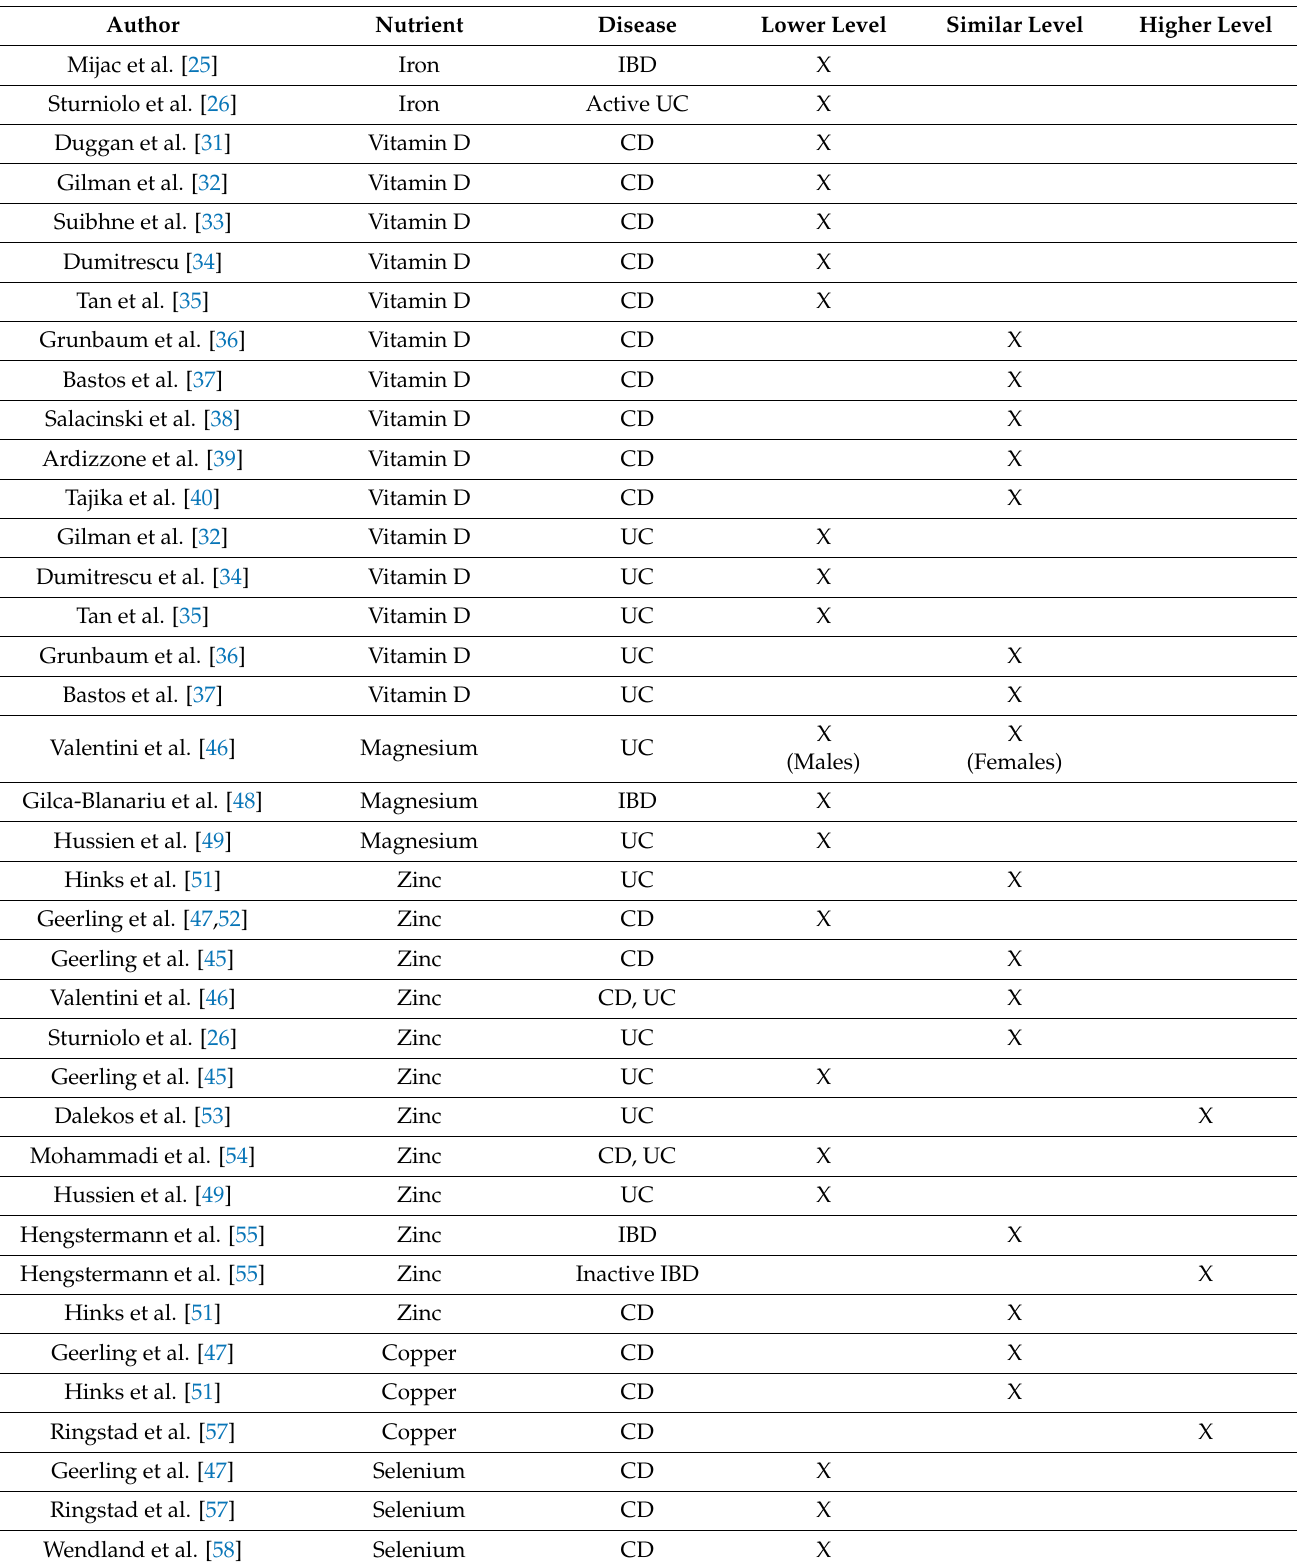
Table 1. Summary of literature reports on nutrient deficiencies in IBD